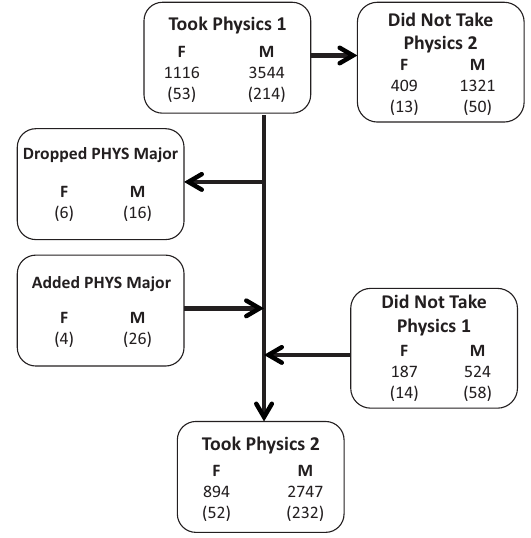
FIG. 1. Tracking students through the introductory physics se- quence. The chart above shows the numbers of males and females who took Physics 1 (cid:1) between spring 2004 and spring 2008 (cid:2) and Physics 2 (cid:1) between fall 2004 and spring 2009 (cid:2) . The numbers in parentheses are the number of male and female physics majors (cid:1) PHYS (cid:2) at each step. Males and females are about fractionally equal at every step of the chart, except in the percentage of physics majors in Physics 2.